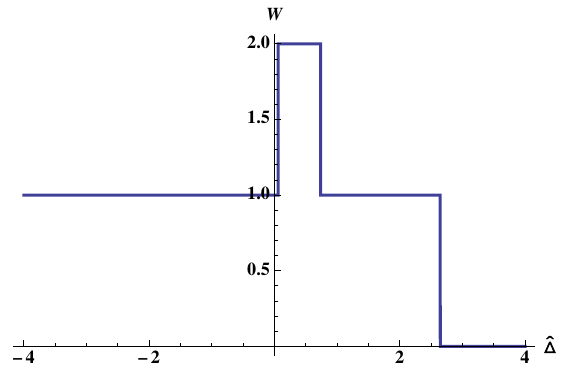
FIG. 8. The number of FEL growing modes calculated from Eq. (35) for an electron beam with the energy distribution shown in Fig. 7(a), and ^(cid:2) p ¼ 1 .